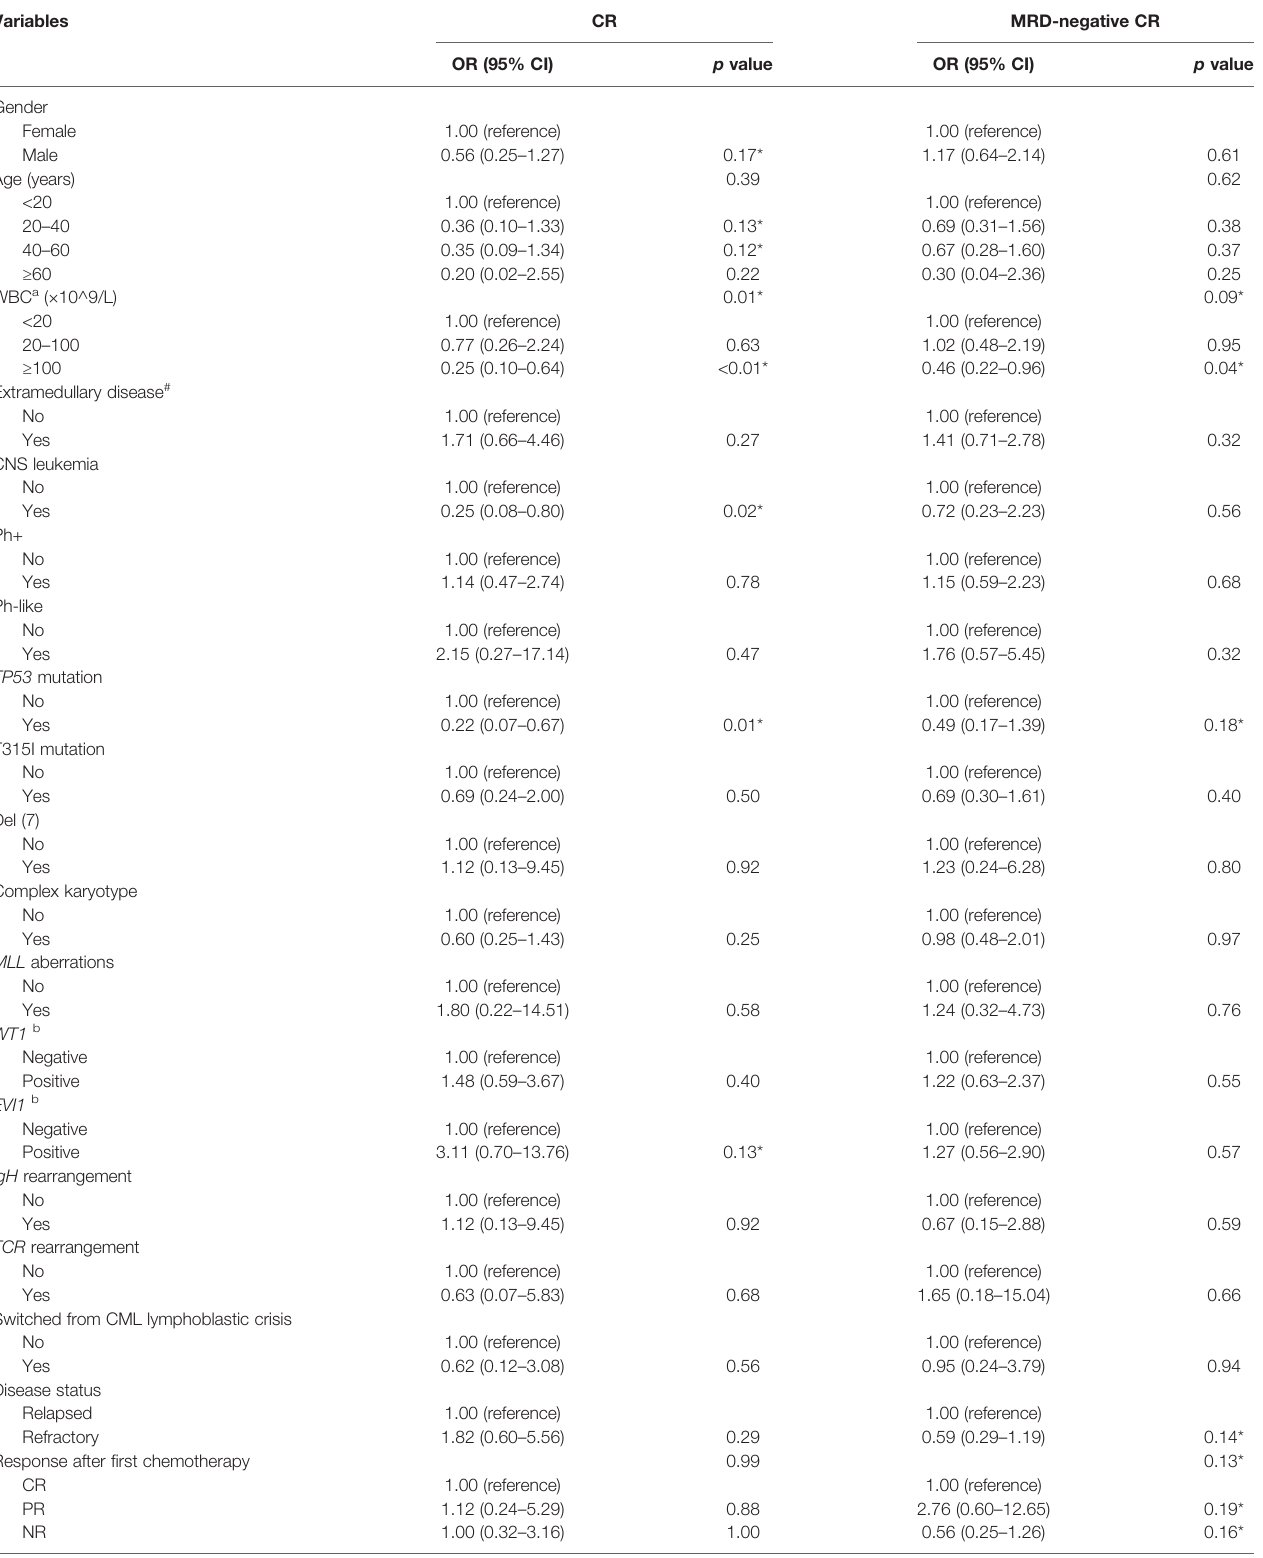
TABLE 2 | Univariate logistic regression analyses of the clinical characteristics of r/r B-ALL patients associated with CR and MRD-negative